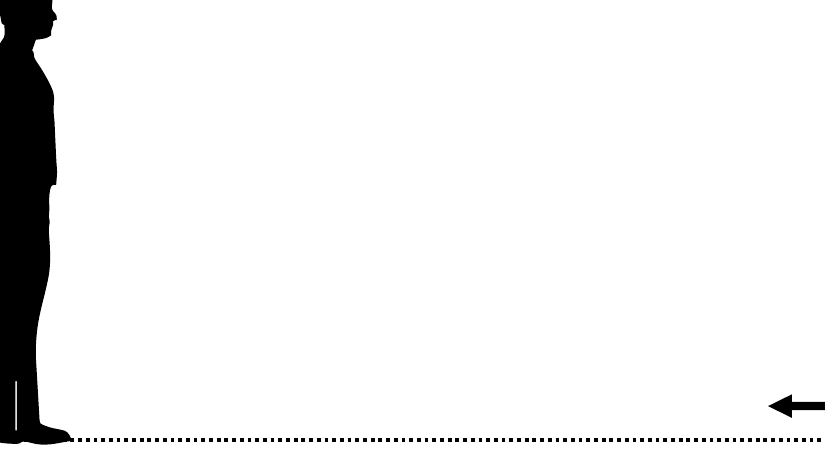
Figure 1. Male silhouette used in the present study. Subjects could place a point on the template to indicate preferred